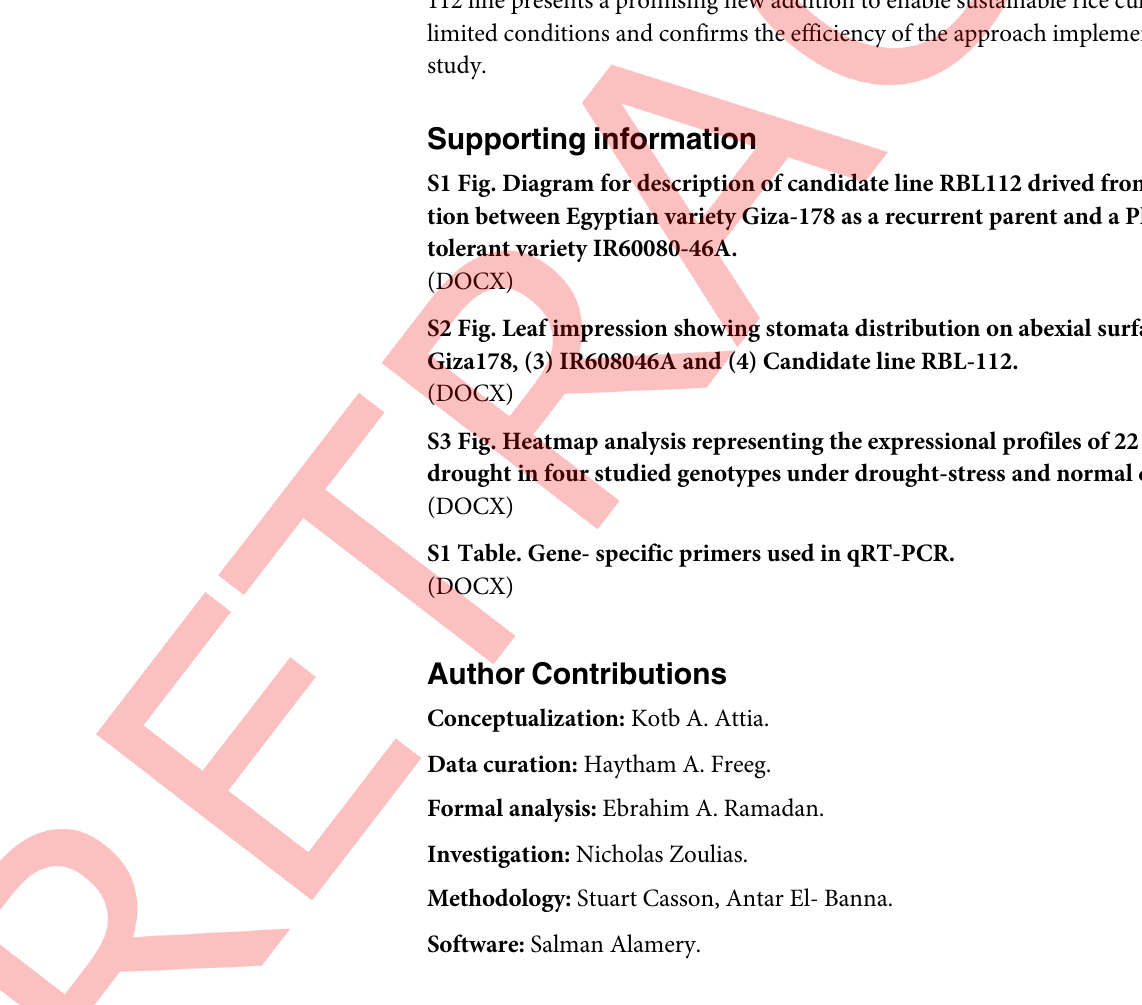
S3 Fig. Heatmap analysis representing the expressional profiles of 22 gene response to drought in four studied genotypes under drought-stress and normal conditions. S1 Table. Gene- specific primers used in